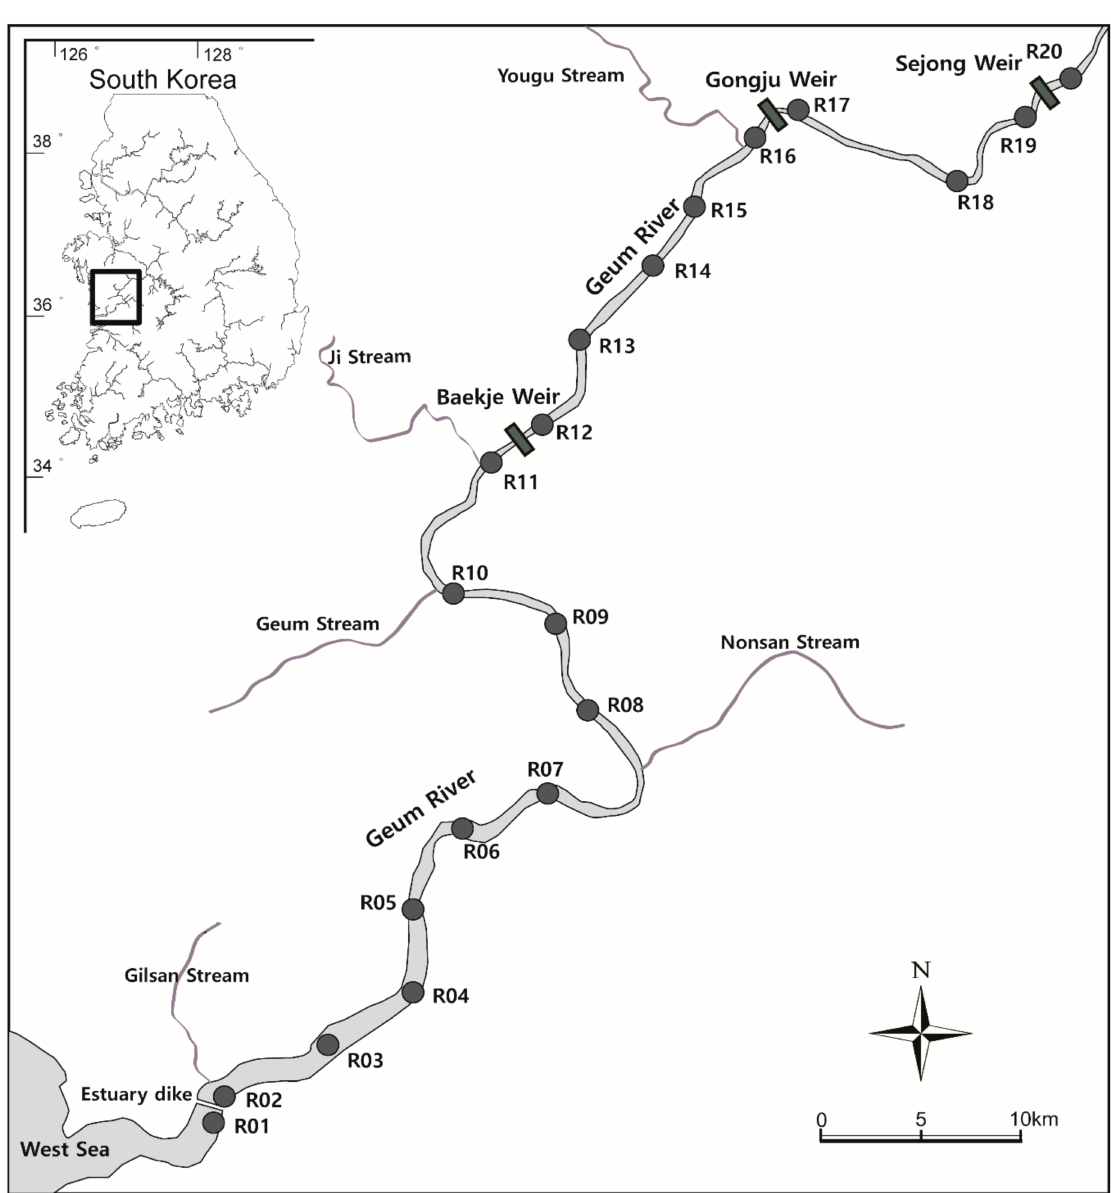
Figure 1. A map showing the study sites. Black circles are sites with installed VR2W acoustic